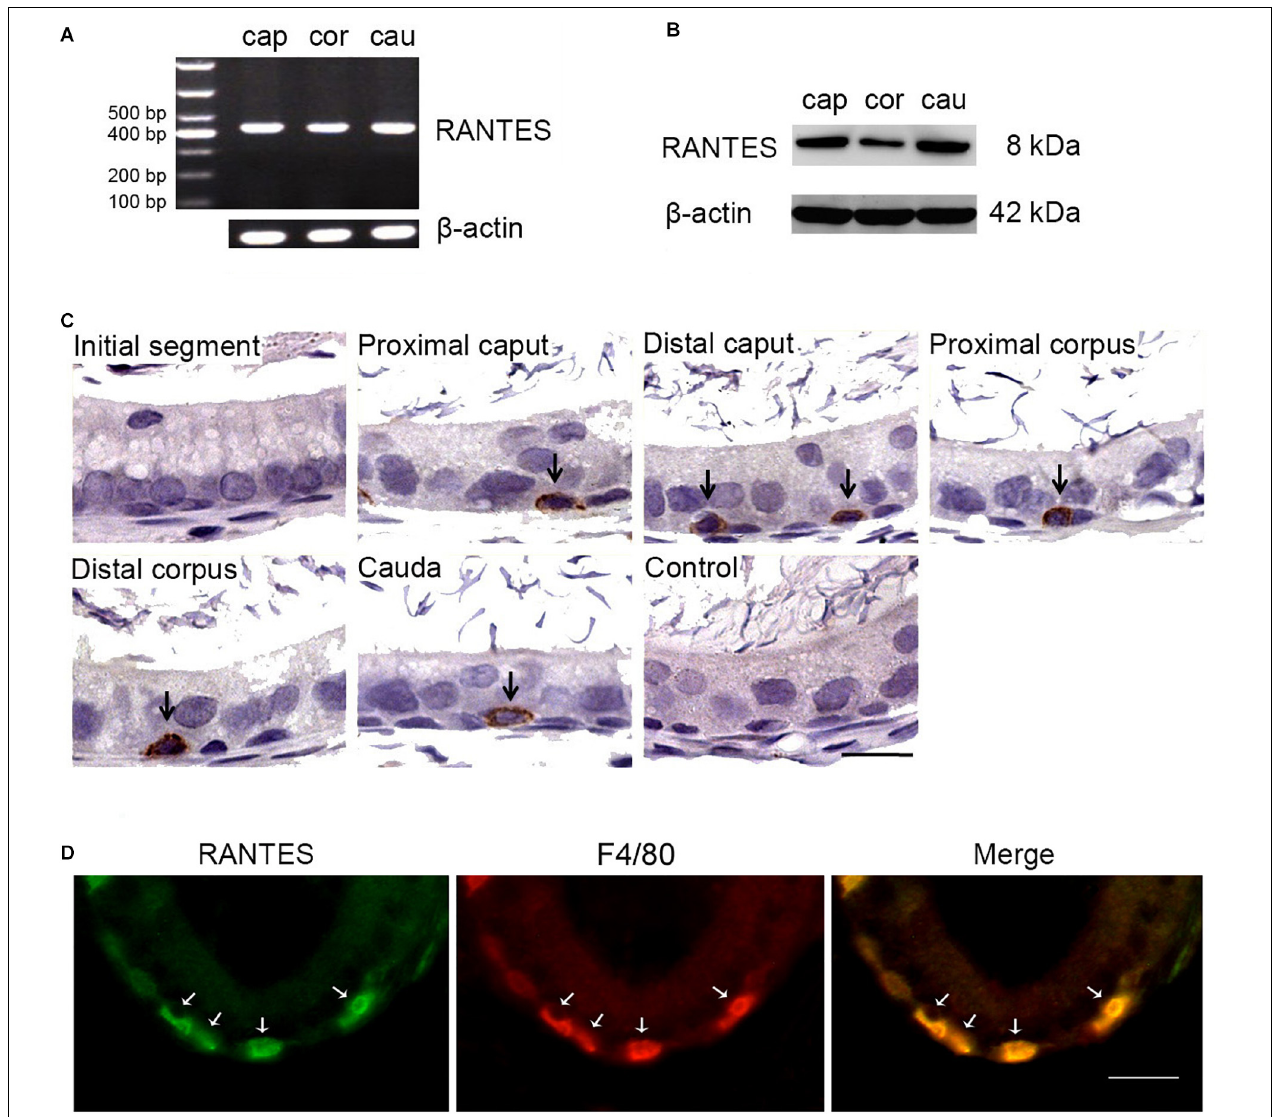
FIGURE 1 | Expression and cellular localization of RANTES in the adult rat epididymis. (A) RT-PCR analysis of RANTES in the caput (Cap), corpus (Cor) and cauda (Cau) regions of the epididymis. The PCR products were found in all three regions. (B) Protein extracted from different segments of the epididymis was analysis by WB. RANTES was detectable in the caput (Cap), corpus (Cor) and cauda (Cau). (C) Immunohistochemistry of RANTES in rat epididymis. Positive reactions were found restricted in partial basolateral cells (black arrows) of the epididymal ducts. (D) The cellular location of RANTES in cauda epididymis was detected by double IF. The green signal of RANTES (Alexa 488 labeled) coincide with the red signal of F4/80 (Cy3 labeled). White arrows: positive signals for RANTES or F4/80. Bar = 20 µ